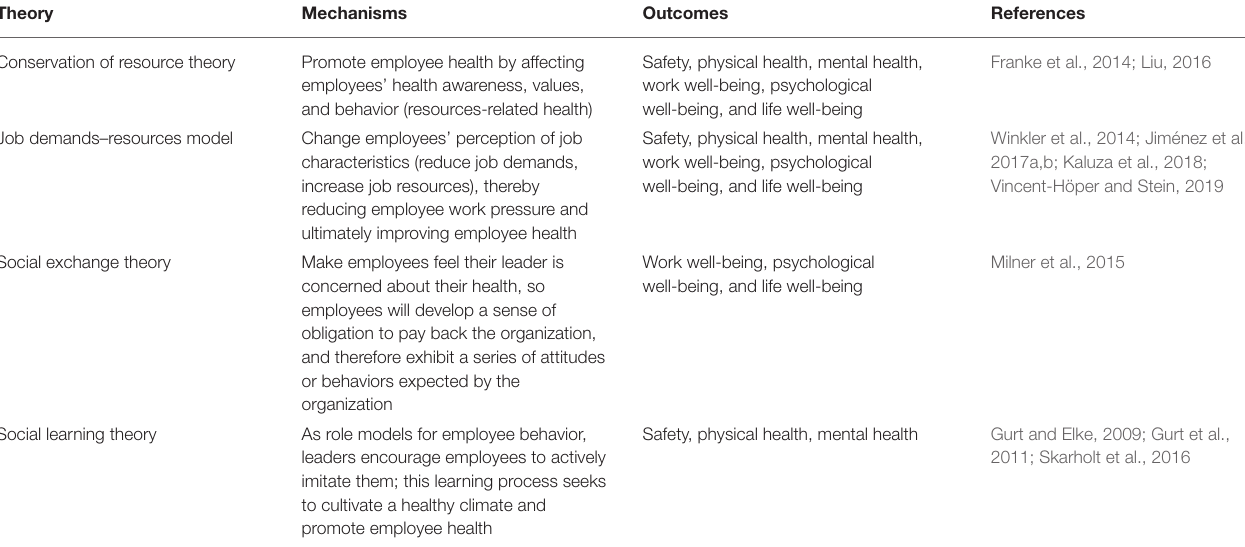
TABLE 3 | Summary of